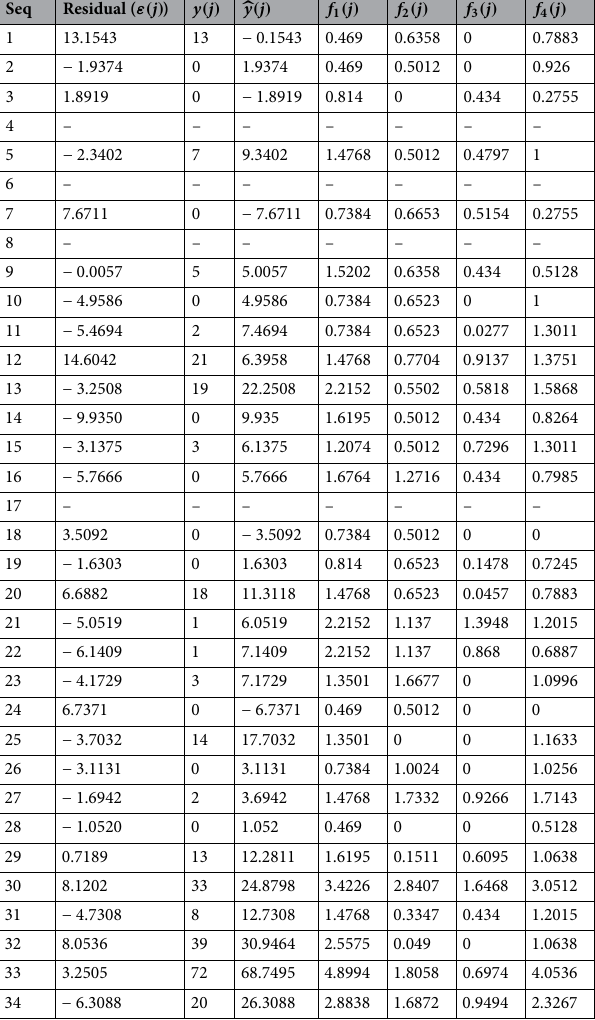
Table 6. Fitting value of each variable after removing abnormal points from test data.